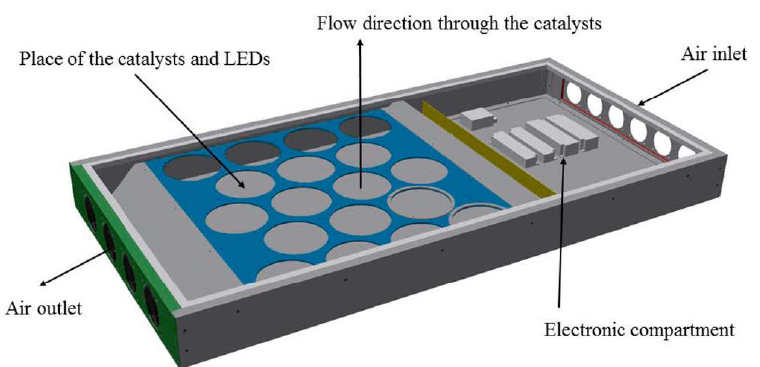
Figure 10. Model of an air purifier built by Schnabel et al. (Reprinted/adapted with permission from Ref.